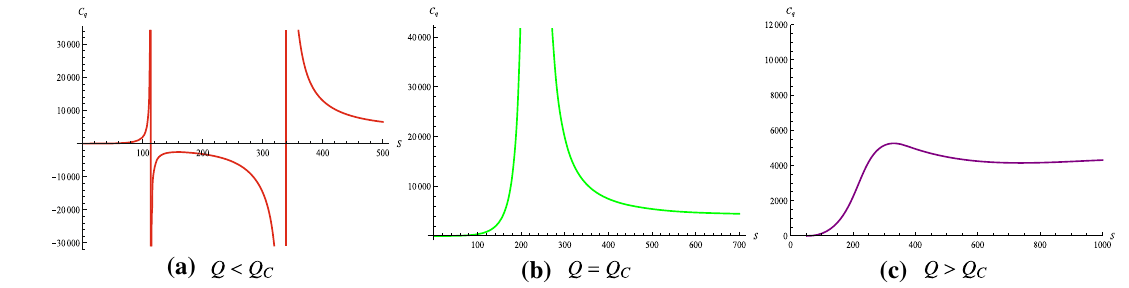
Fig. 5 The figure shows C Q vs S for different charges Q for the charged Gauss–Bonnet AdS black hole. Here parameters α = 1 and l = 20